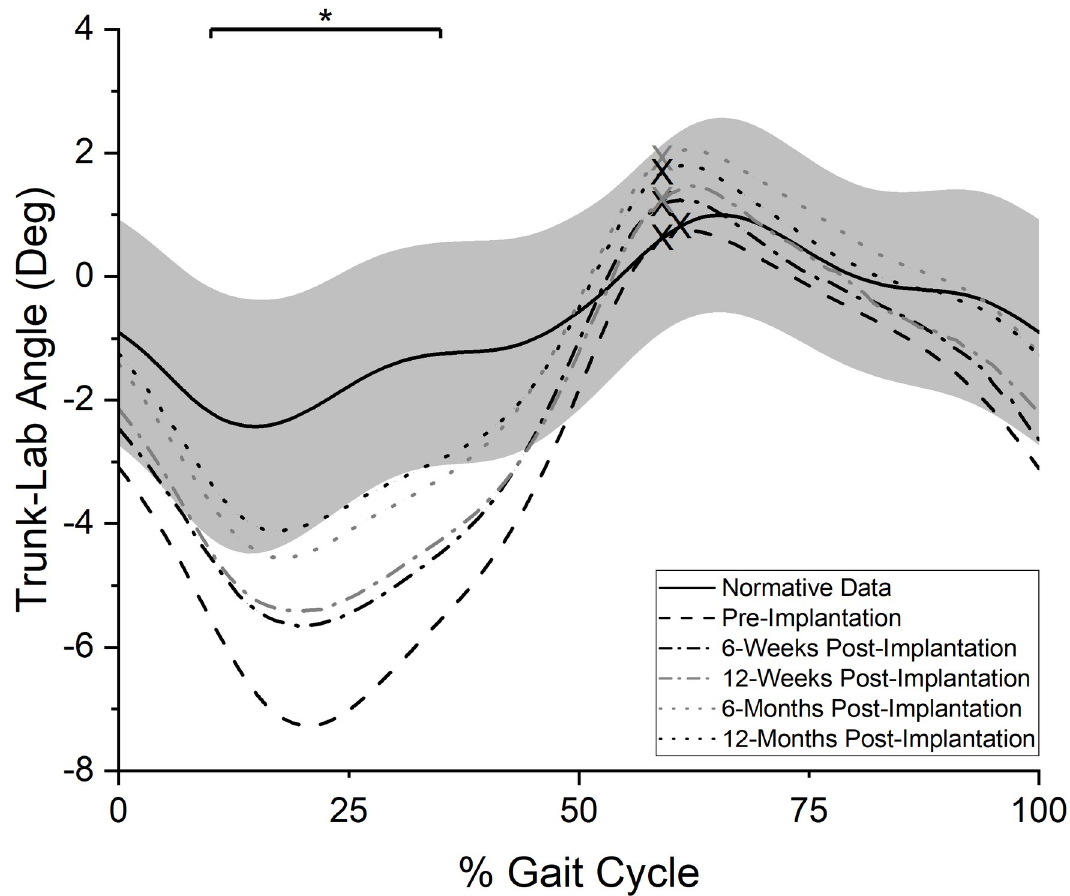
Fig 4. Frontal plane trunk angle. Averaged, normalized frontal plane trunk angle values over the prosthetic side gait cycle (0% = POP side heel strike, 100% = subsequent POP side heel strike). “X” marks represent the mean toe-off event for each curve. Positive values indicate ipsilateral shoulder elevation relative to the lab space, while negative values indicate ipsilateral shoulder declination relative to the lab space. Solid black line indicates reference values for individuals without TFA while grey band indicates plus or minus one standard deviation of the reference data. � : period of statistically significant difference in pre-implantation test values from reference data (p = 0.01).